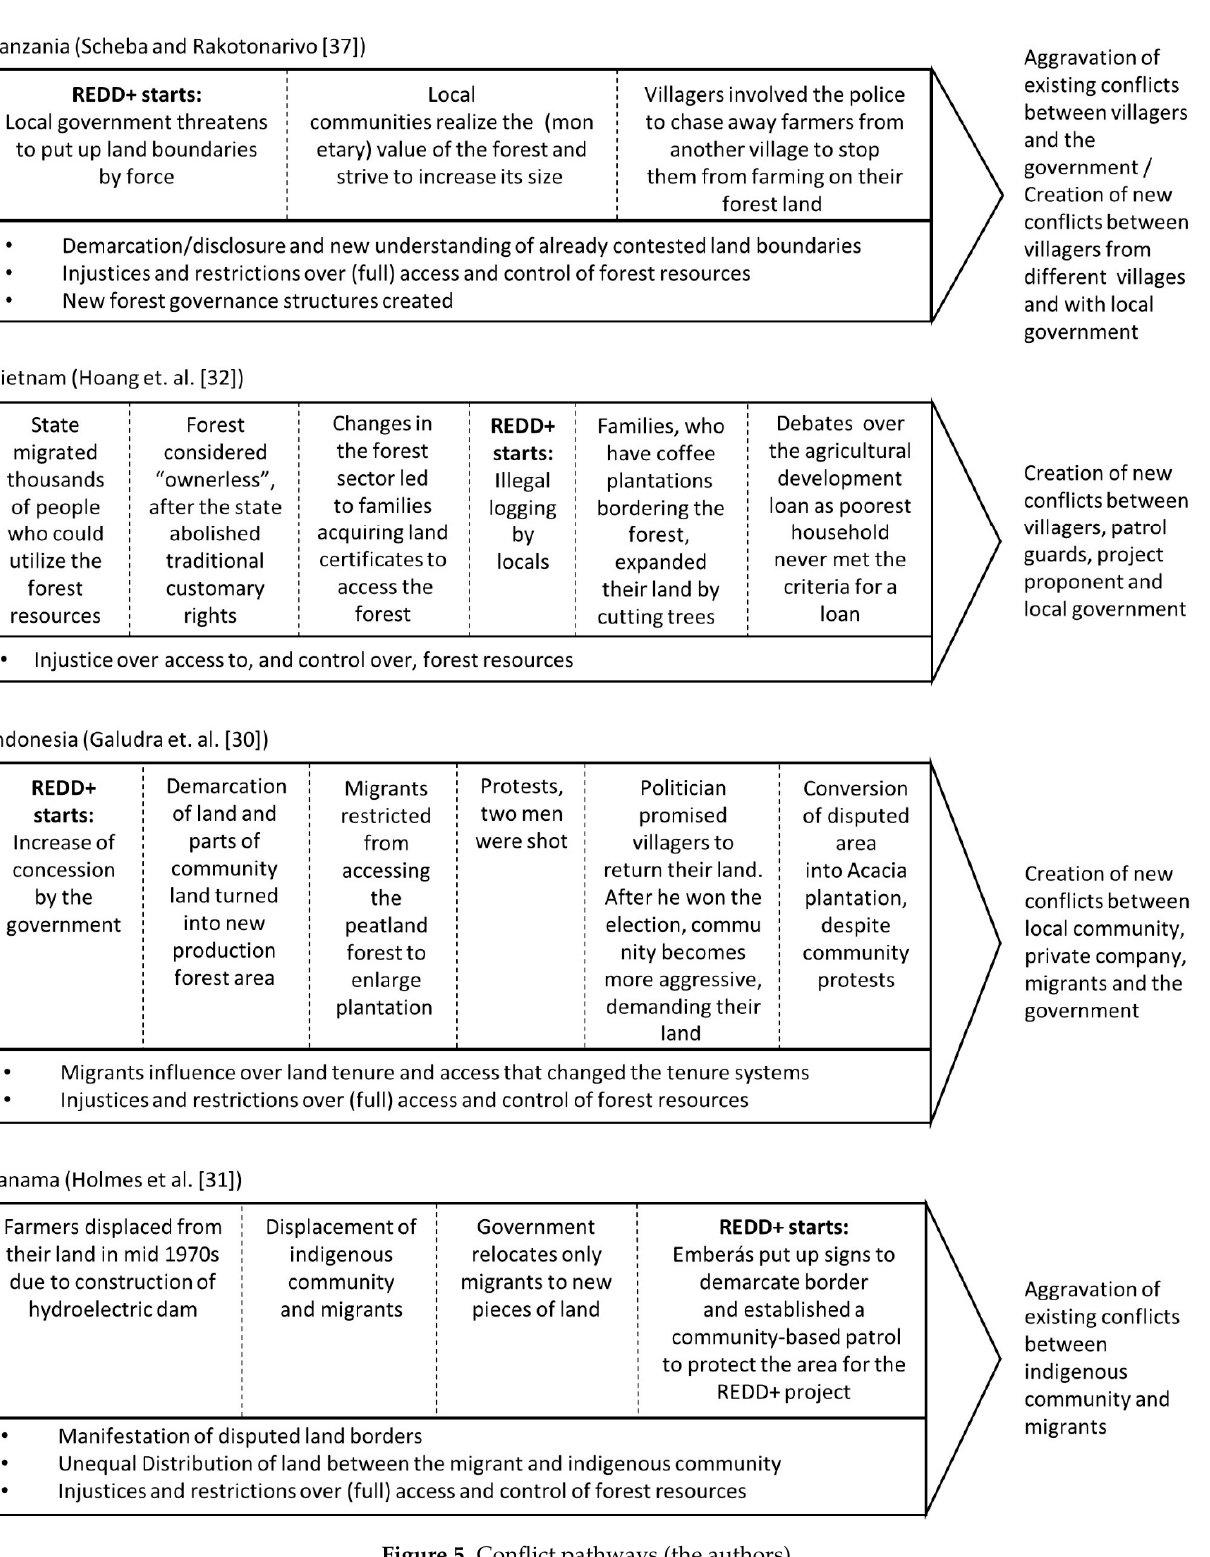
Figure 5. Conflict pathways (the authors).